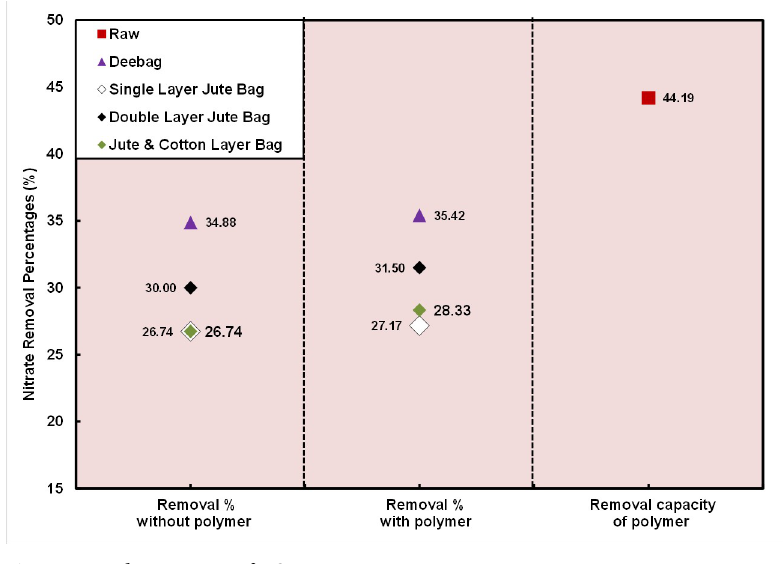
Fig 6. Removal percentages of NO 3-